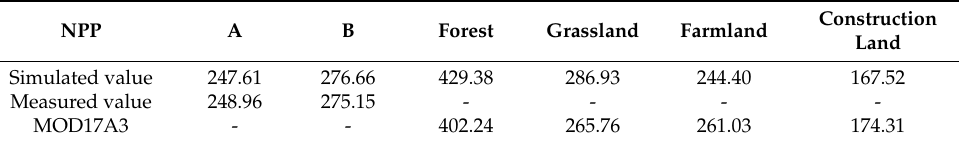
Table 2. Simulated NPP, measured NPP and MOD17A3 for different land use types (g C/(m 2 ·